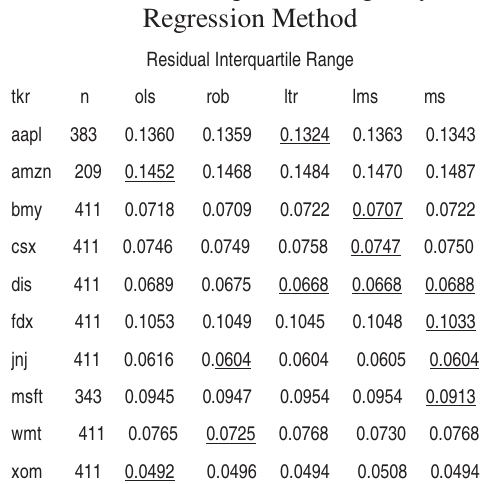
Table 3. Inter-quartile Ranges by Regression Method